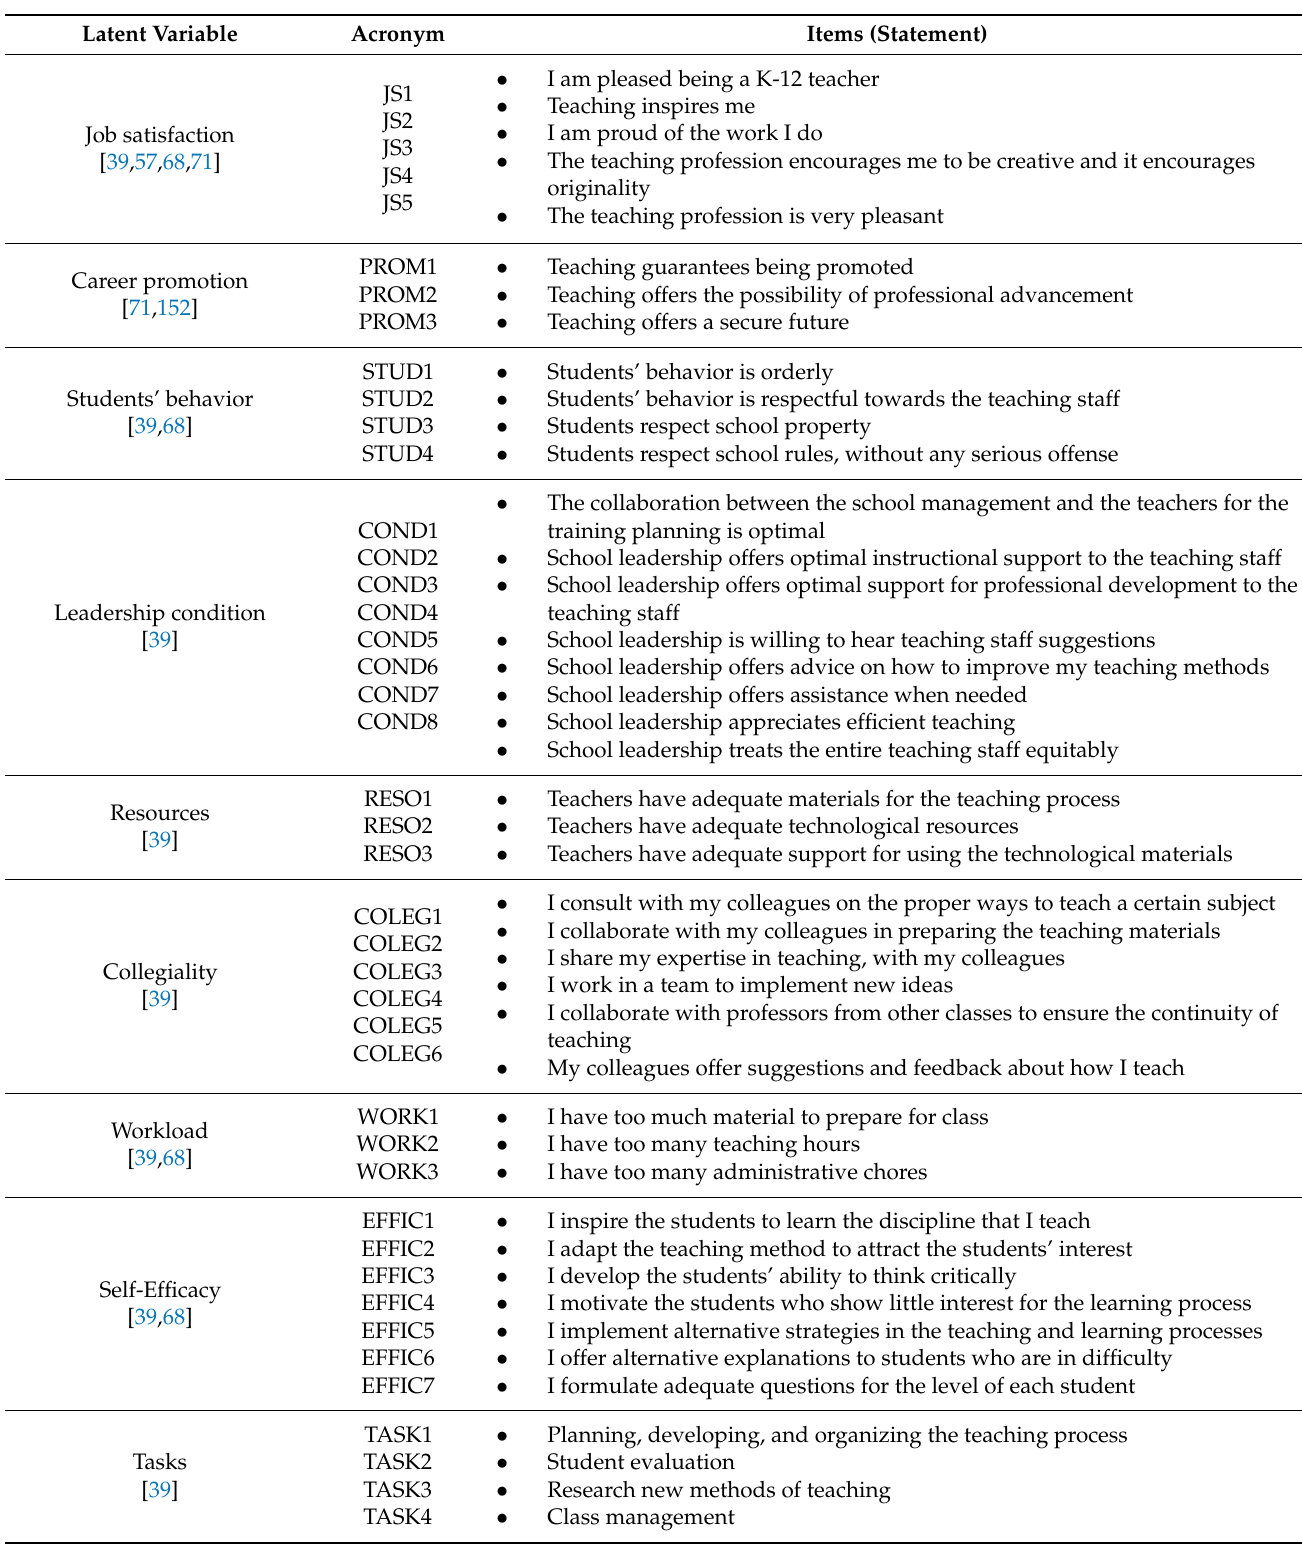
Table A1. Latent variables and